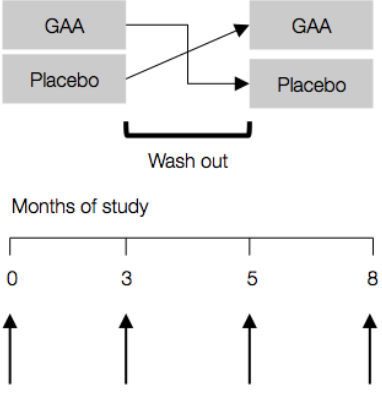
Figure 1 . Study design with sampling intervals ( ↑ ). GAA—guanidinoacetic acid. Figure 1. Study design with sampling intervals ( Ò ). GAA—guanidinoacetic